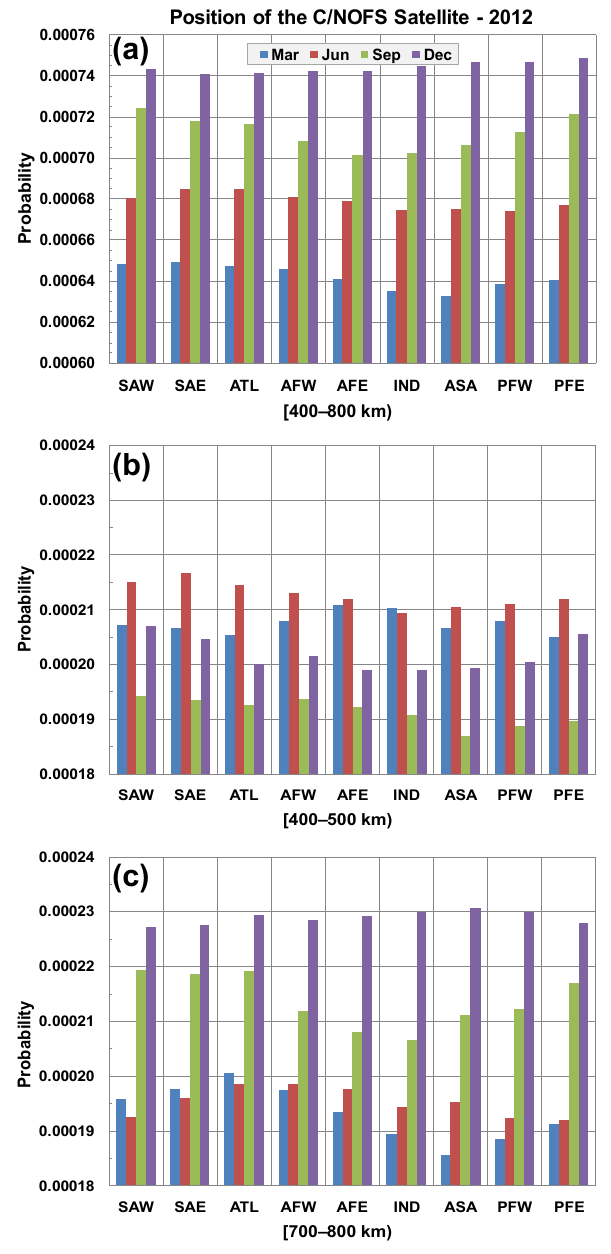
Figure 4. Probability distributions of the presence of the C/NOFS satellite within each combination of longitude sector (on a per degree basis) and season of 2012 for the altitude ranges: (a) [400 km, 800 km); (b) [400 km, 500 km); and (c) [700 km, 800 km). The maximum variations of the probabilities in the three panels are 18.37 %, 16.04 %, and 24.87 %, respectively.